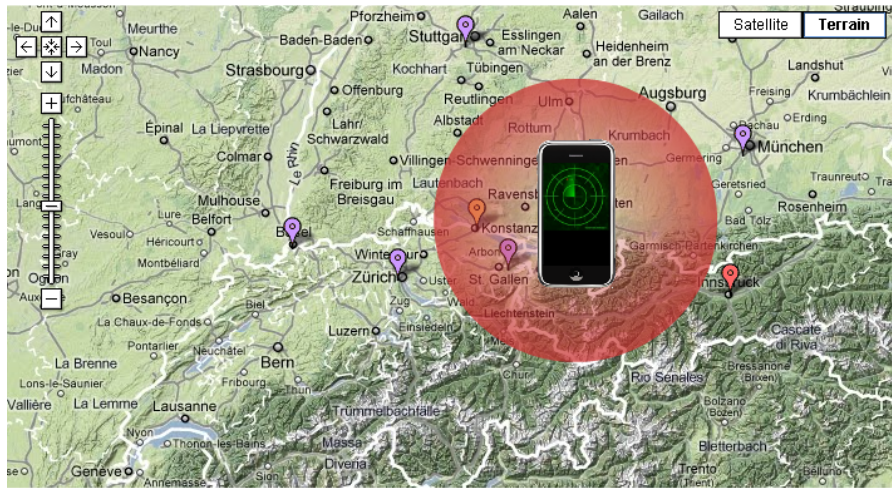
Figure 2. The concept of UrbanRadar mobile application (Source: